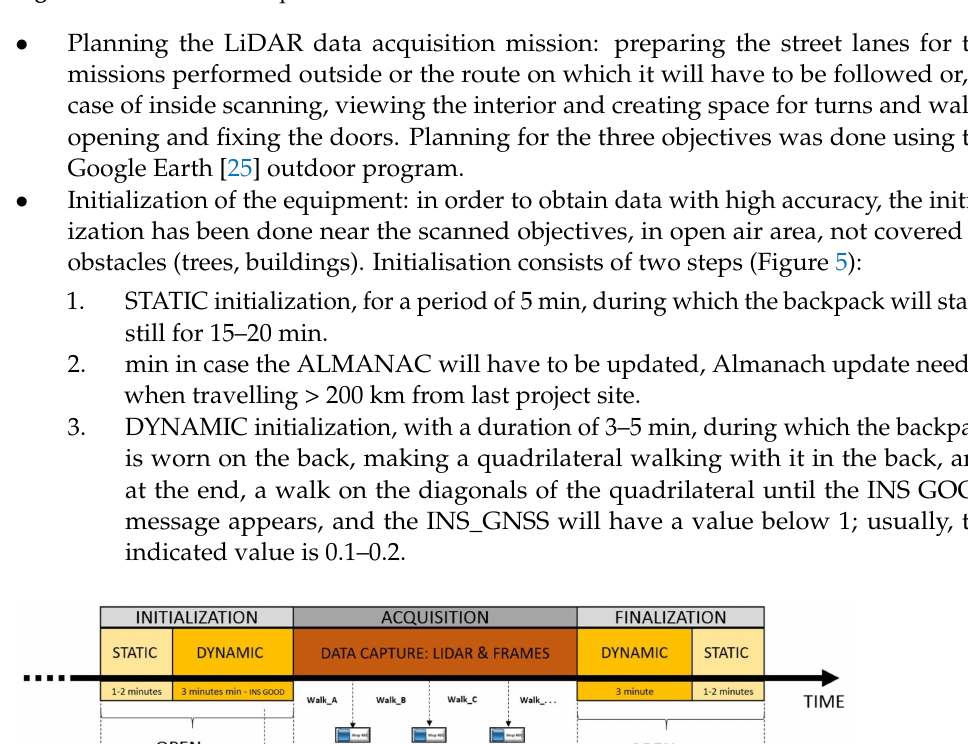
Figure 4. Fused SLAM Acquisition.